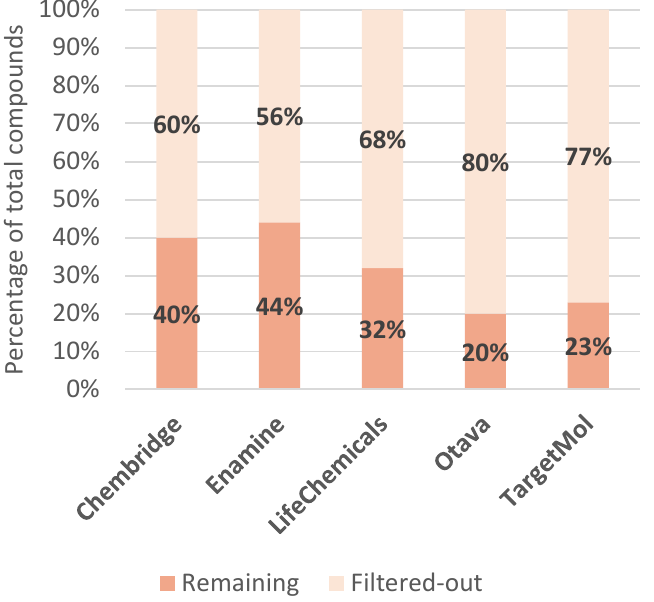
Figure 8. Compound (relative) retention after post-filtering for REOS, PAINS, Aggregators and the Lipinski rule of 5 (one rule break allowed) on protein–protein-interaction-inhibitor-targeted libraries.